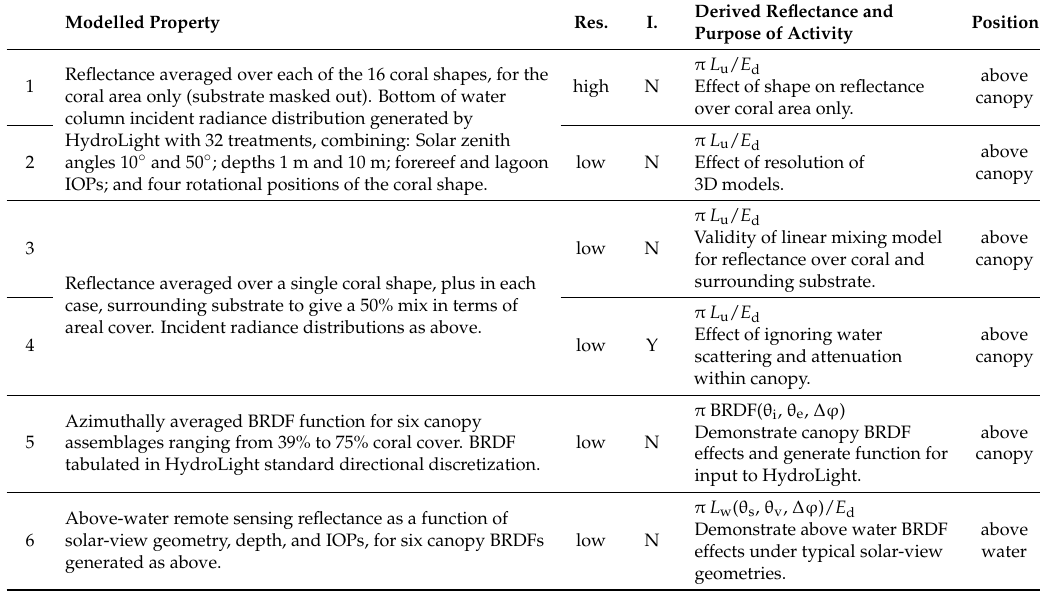
Table 1. Different properties and treatments modelled in this study and the aim of each investigation. “Res.” indicates if the high- or low-resolution coral structure models were used. “I.” indicates if interstitial scattering and attenuation by the water around the coral shapes was included (N-No, Y-Yes). “Position” indicates the notional location of the estimated